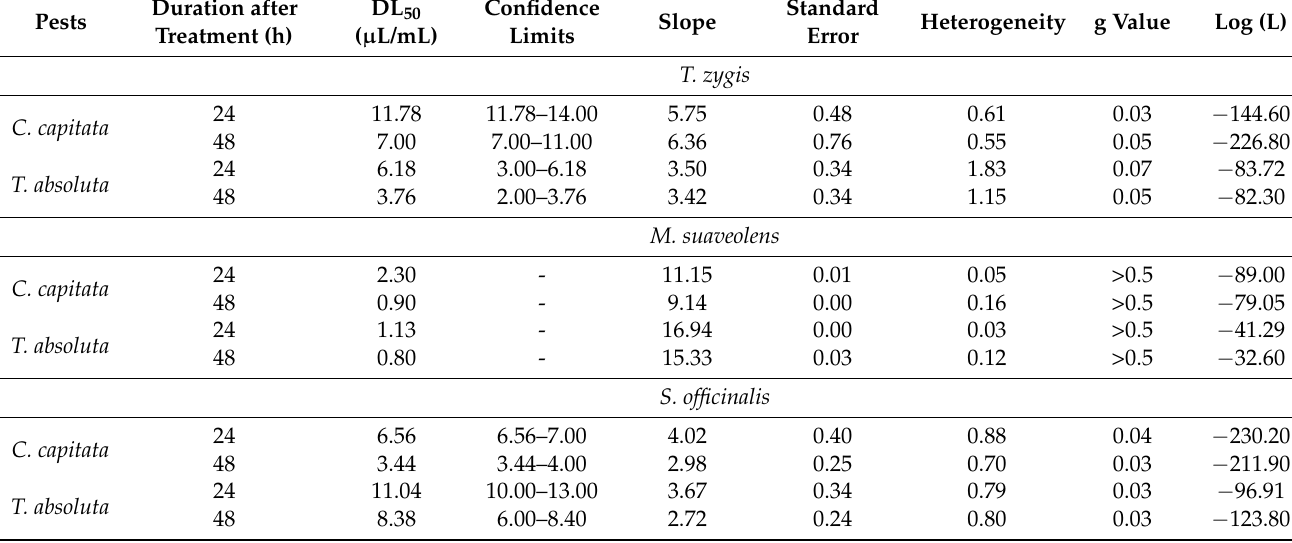
Table 3. LD 50 ( µ L/mL) of the essential oils of T. zygis L., S. officinalis L. and M. suaveolens